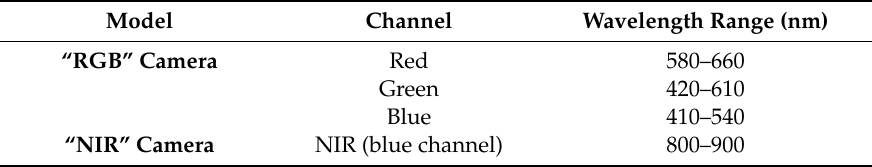
monochromator fitted with an integrating sphere. Table 3. Sony α 5100 camera band sensitivities. Sensitivities were measured using a double